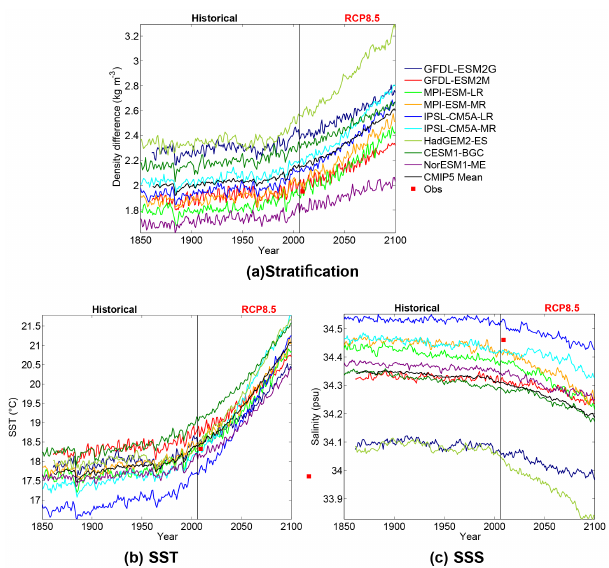
Figure 1. Time series of global mean surface stratification, SST and SSS for historical run and RCP8.5 over 1850–2100. Surface stratification is defined as the density difference between 200m and the surface. Red square indicates observations from the WOA2009